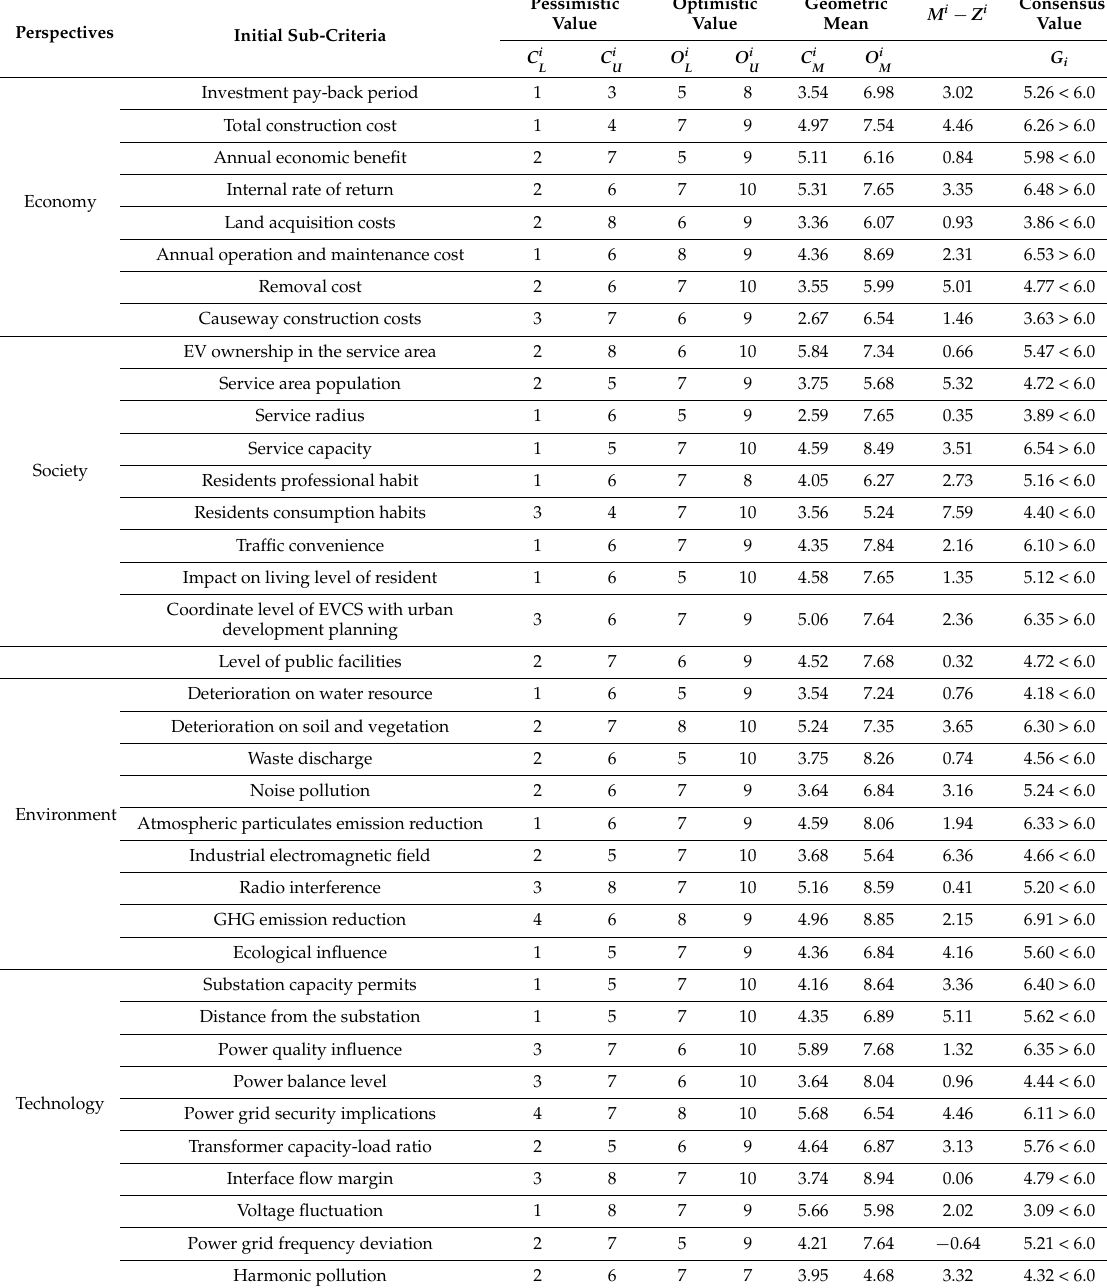
Table 3. Calculation results of evaluation sub-criteria based on